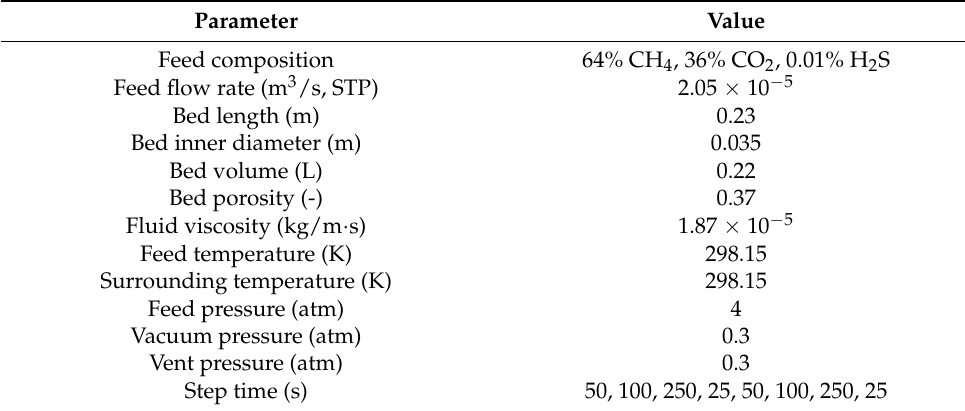
Table 6. Adsorption bed parameters and operating conditions for the basic